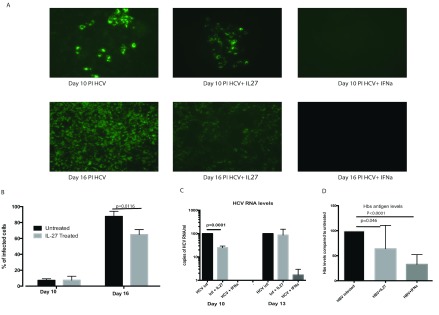
Impact of IL-27 in HCV replication
in vitro.Huh7.5 cells were infected with HCV and treated with IL-27 (100ng/ml). (
A) Immuno-fluorescence assays were performed during the experimental period to assess for antiviral activity. (
B) Infected cells were counted and the percentage of infected cells compared to the control untreated well. (
C) Supernatants from cells infected with HCV and control untreated wells were analysed by real time RT-PCR and represented as copies of HCV/ml of supernatant. (
D) HBs antigen levels as assessed by ELISA. Results from three independent experiments are shown (p-value assessed using t-test). IL, interleukin; PI, post-infection; HCV, hepatitis C virus; IFN, interferon; HBs, hepatitis B surface antigen; HBV, hepatitis B virus; Inf, infection.